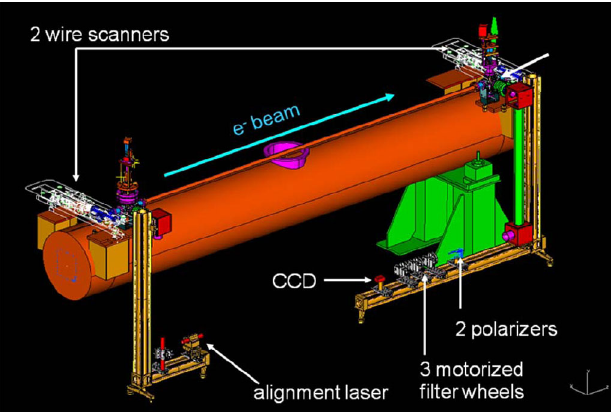
FIG. 3. A schematic of the OTR/ODR station on the beam line at JLAB showing the optical transport, the CCD camera, the alignment laser, and the wire scanner locations